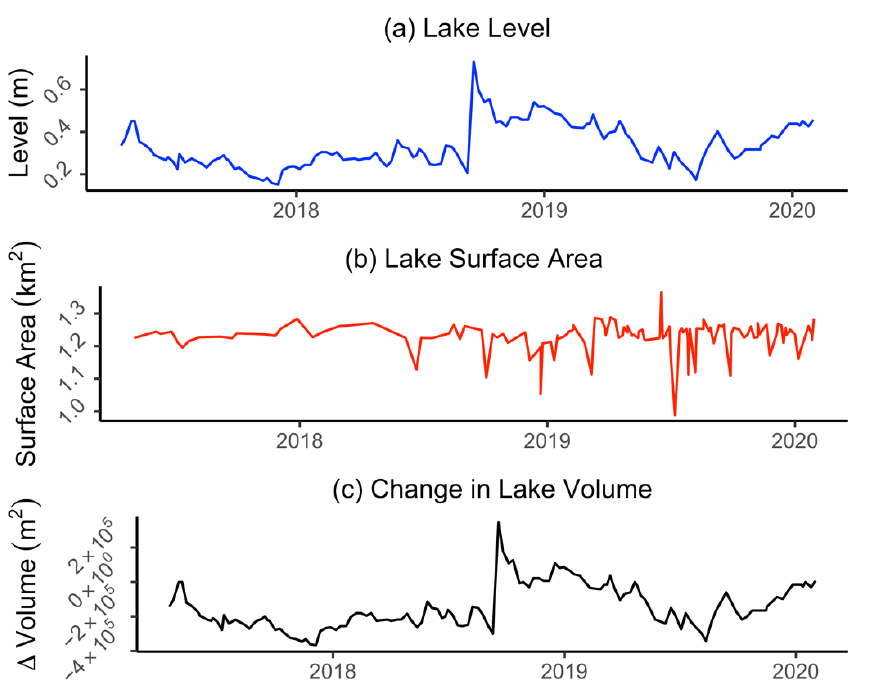
Figure 3. Example time series of ( a ) lake water level, ( b ) lake surface area, and ( c ) change in lake volume in Salters Lake, located in eastern North Carolina.